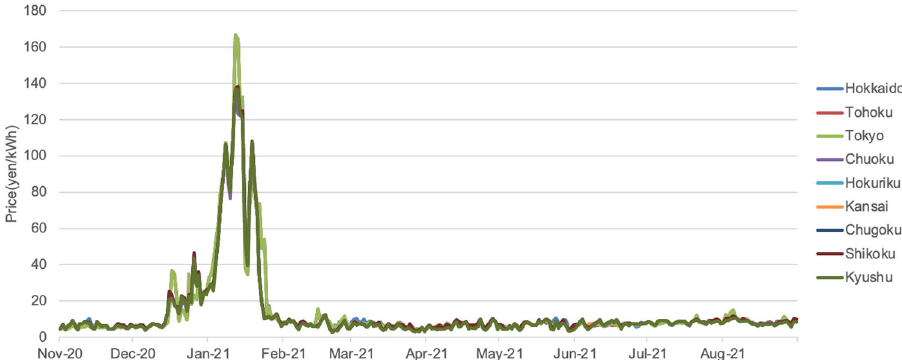
Fig. 2 Electricity price proliferated at the beginning of 2021. The electricity spot market price hit a high record in Japan in January 2021 since the cold grips the country.